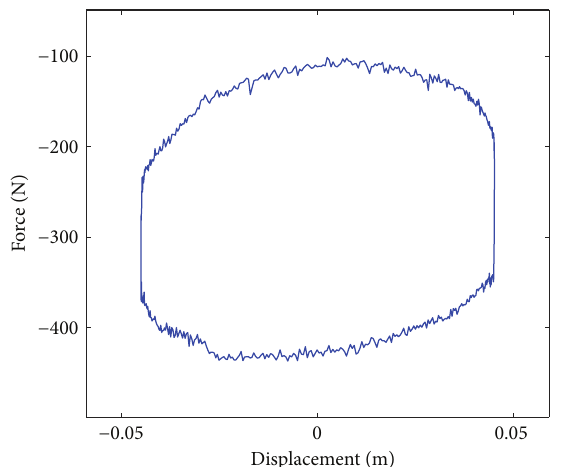
Figure 4: The testing results under the slow sinusoidal